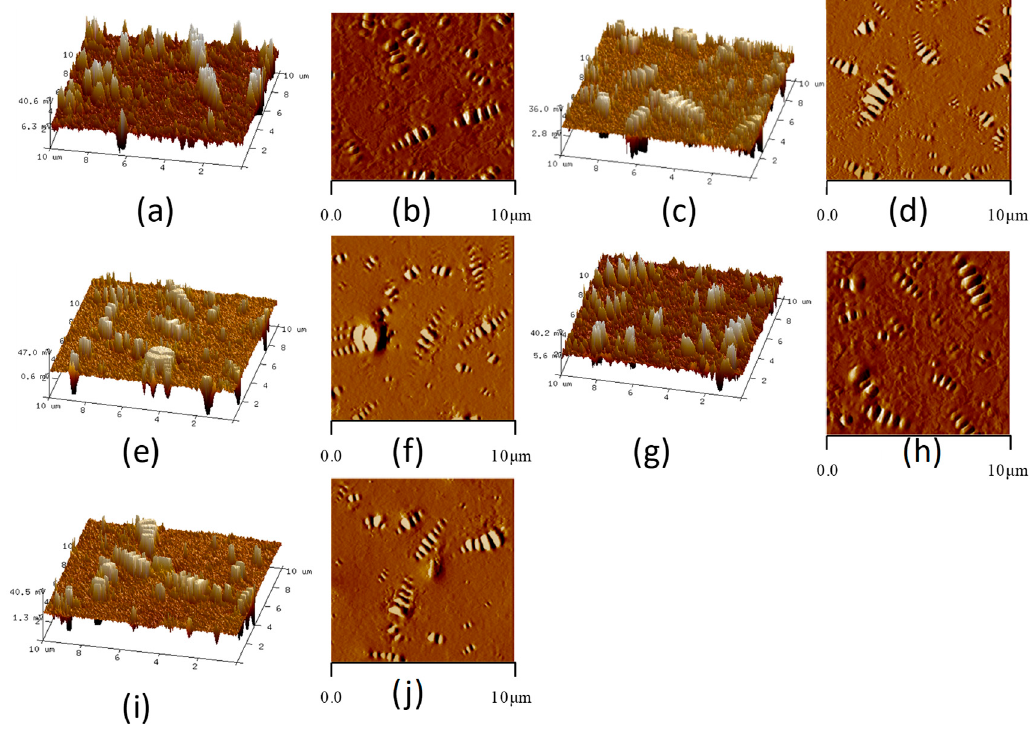
Figure 10. AFM images of bitumen with different SBS contents after aging ( a , c , e , g , i are the three ‐ dimensional height images, the content of SBS are 0, 3%, 4%, 5%, and 6%, respectively; b , d , f , h , j are the two ‐ dimensional height images, the content of SBS are 0, 3%, 4%, 5%, and 6%, respectively).